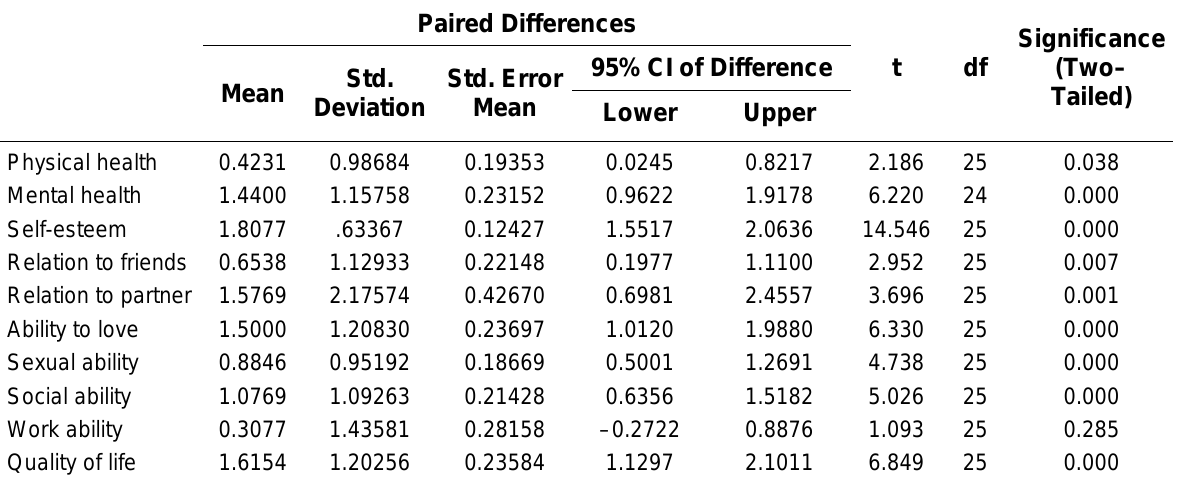
Study of 26 Patients Who’s Ratings of Self-Esteem (Feelings about Themselves) were Changed